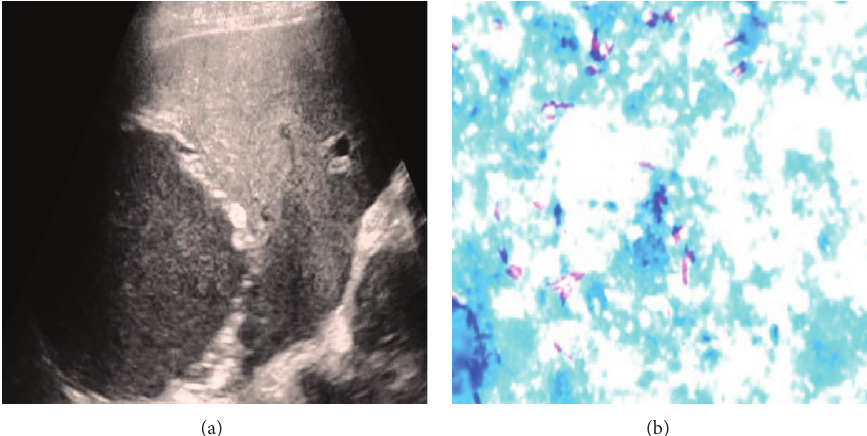
Figure 2: Tubercular liver abscess. (a) Ultrasonography image of a large hypoechoic lesion involving the right lobe of liver and (b) aspirated pus on ZN staining depicts acid fast